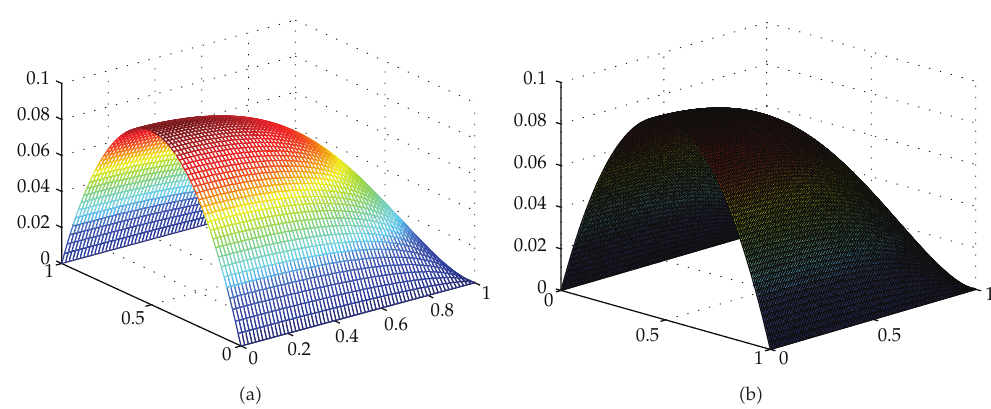
Figure 1: The conforming FE solution (cid:2) a (cid:3) and the nonconforming FE solution (cid:2) b (cid:3) on the 64 × 64